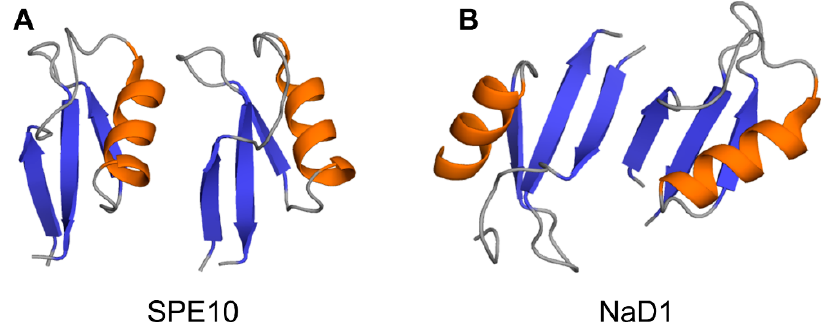
Figure 4. Three-dimensional structures of plant defensin dimers. Cartoons present two different monomer arrangements in the dimer structures of plant defensins ( A ) SPE10 (PDB code 3PSM) [71] and ( B ) NaD1 (PDB code 4ABO) [65]. In SPE10 dimer, the two monomers are packed against each other approximately in a side by side manner, with a beta-sheet of one monomer facing the alpha-helix of another monomer. In NaD1 dimer, the β 1 strands of the two monomers interact, forming an extended beta-sheet structure comprising three beta-strands of each monomer.